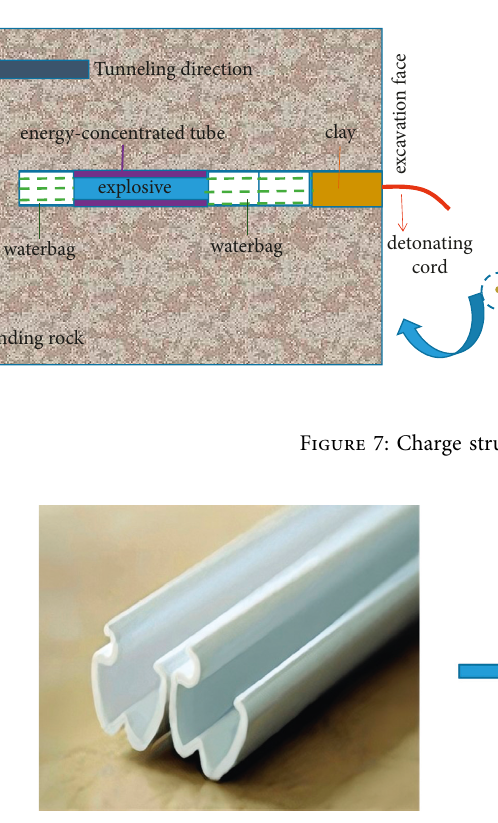
Figure 8: Energy-concentrated tube Table 1: Comparison of cyclic footage between ECHBT and conventional blasting technology [48–58].